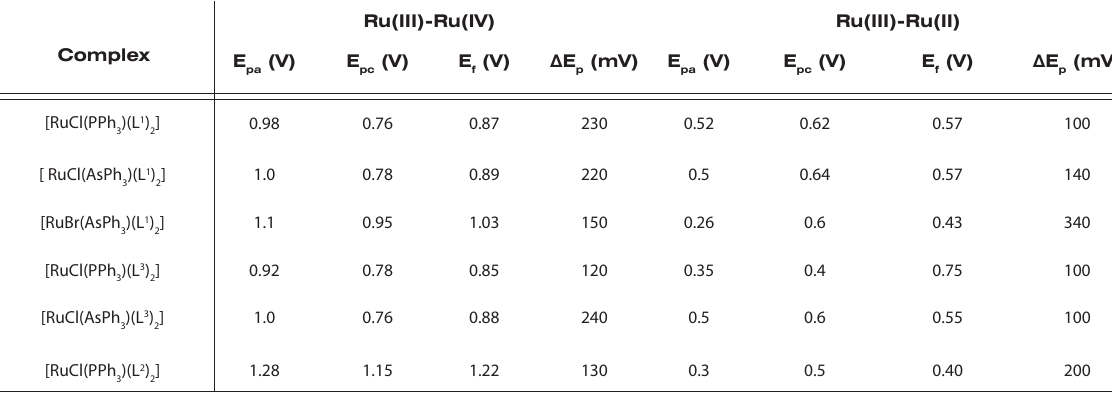
Table 4. Cyclic voltammetric data a of Ru(III) complexes